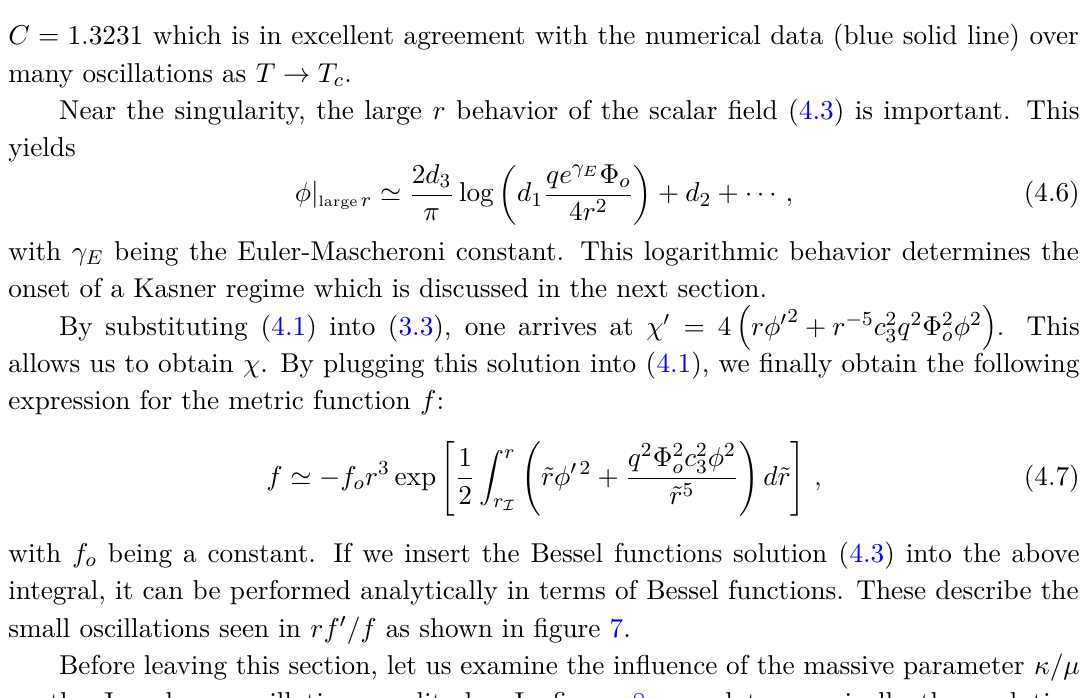
Figure 5 . A comparison of the numerical solution (solid blue curves) of the scalar hair φ and fits to the analytic relation (4.3)(red dashed curves) describing the Josephson oscillations. Here T/T c = 0 . 995 and κ/µ = 1